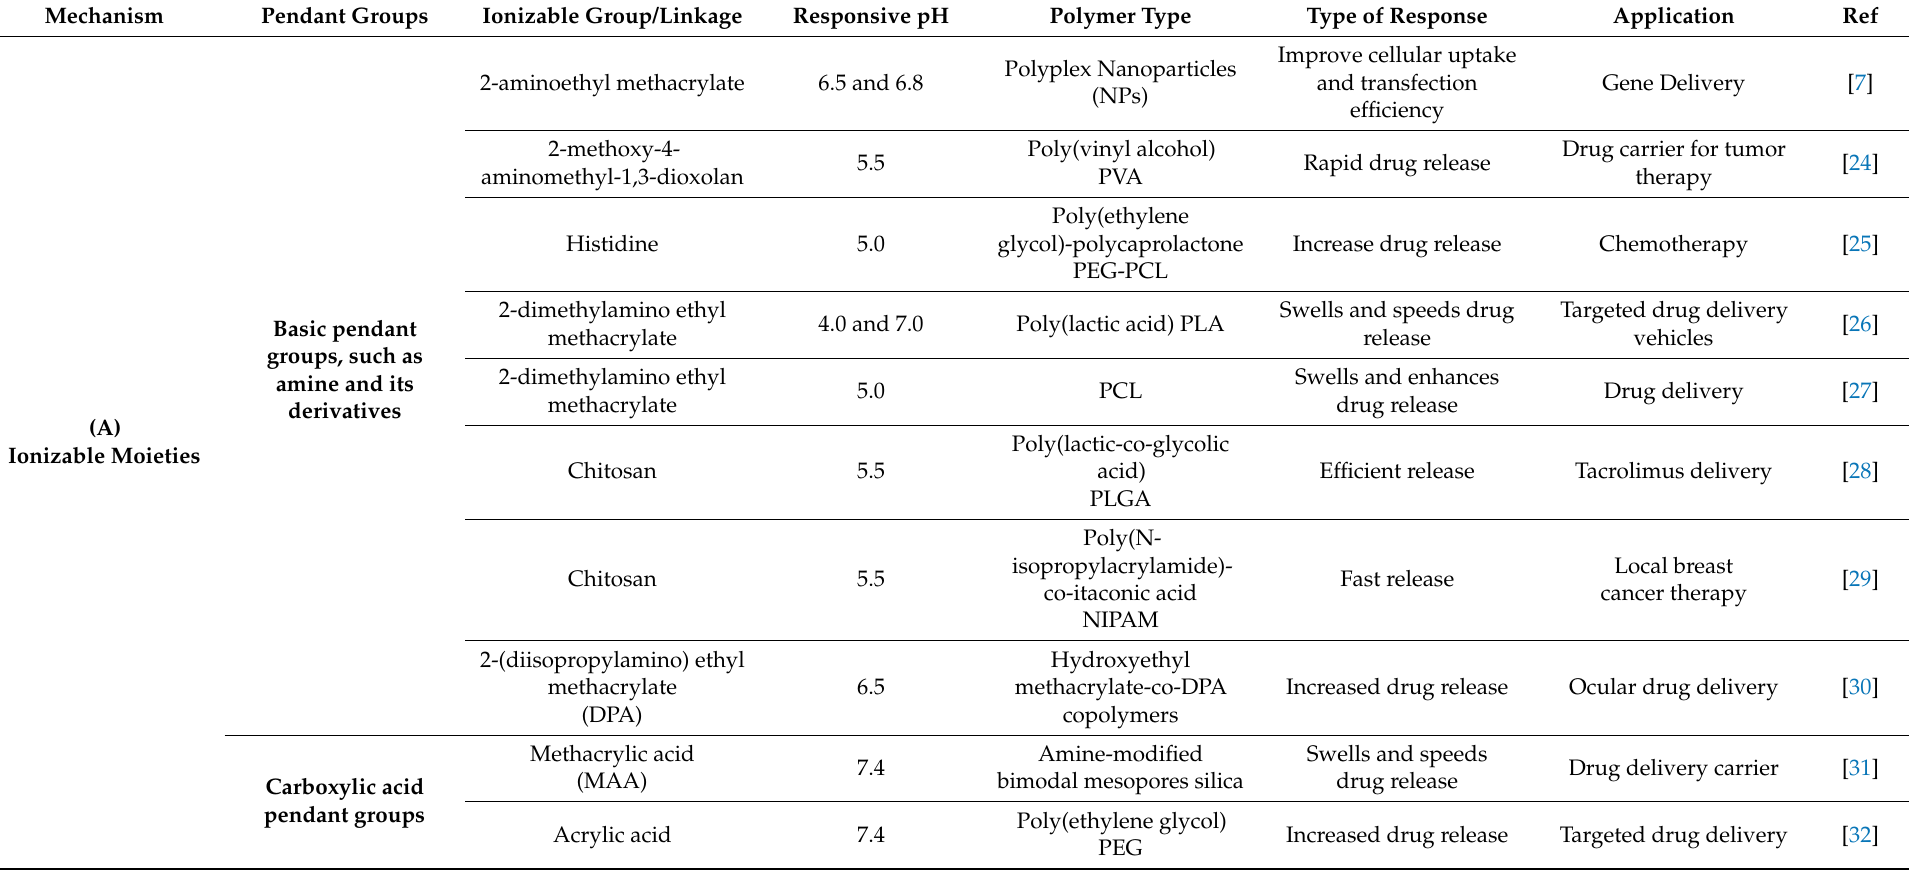
Table 1. pH-responsive polymers categorized by the mechanism (A) Ionizable moieties and (B) Acid-labile linkages, and their